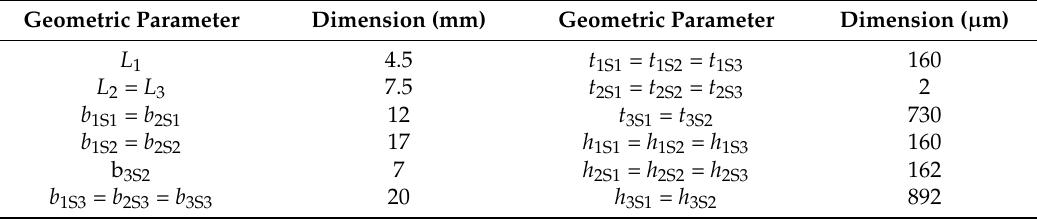
Table 1. Geometric parameters of the equivalent resonator layers of the pVEH